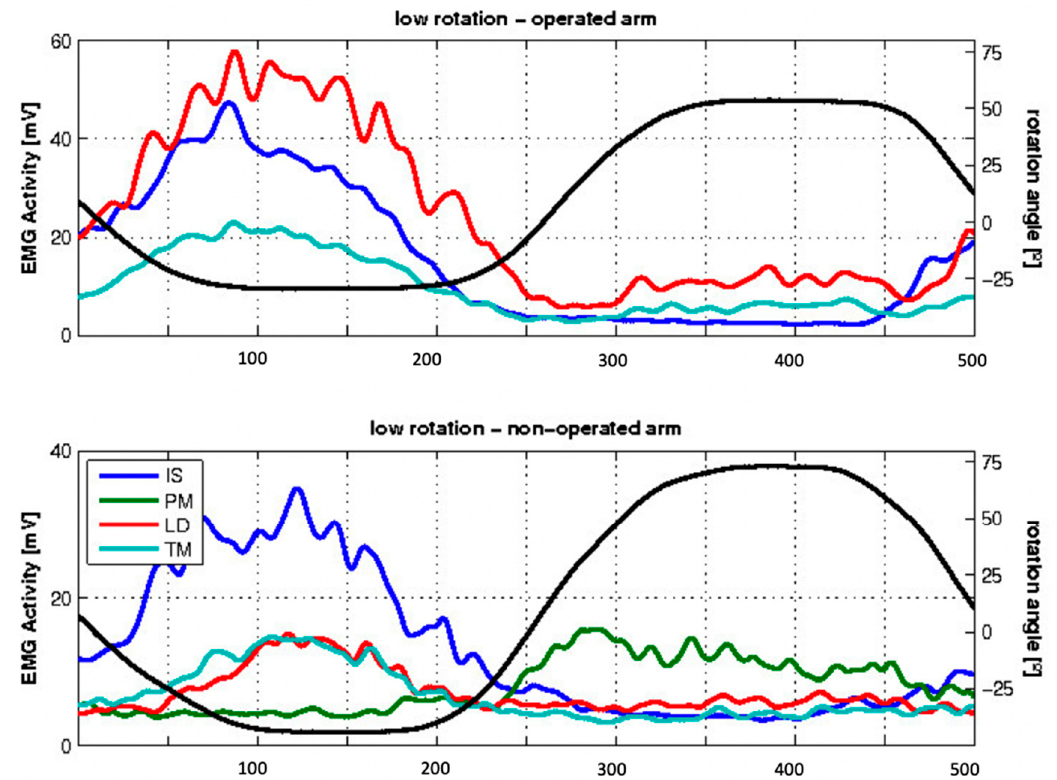
Figure 2. Mean EMG activity of the examined patients during low exorotation. The x-axis indicates the frames, and the y-axis indicates the EMG activity in mV on one the left, represented by colored lines corresponding to different muscles (infraspinatus (IS), pectoralis major (PM), latissimus dorsi (LD), and teres minor (TM).), and the angle of rotation on the right, represented by the black line. The negative values of the angle rotation correspond to the exorotation, and the positive values to the endorotation.